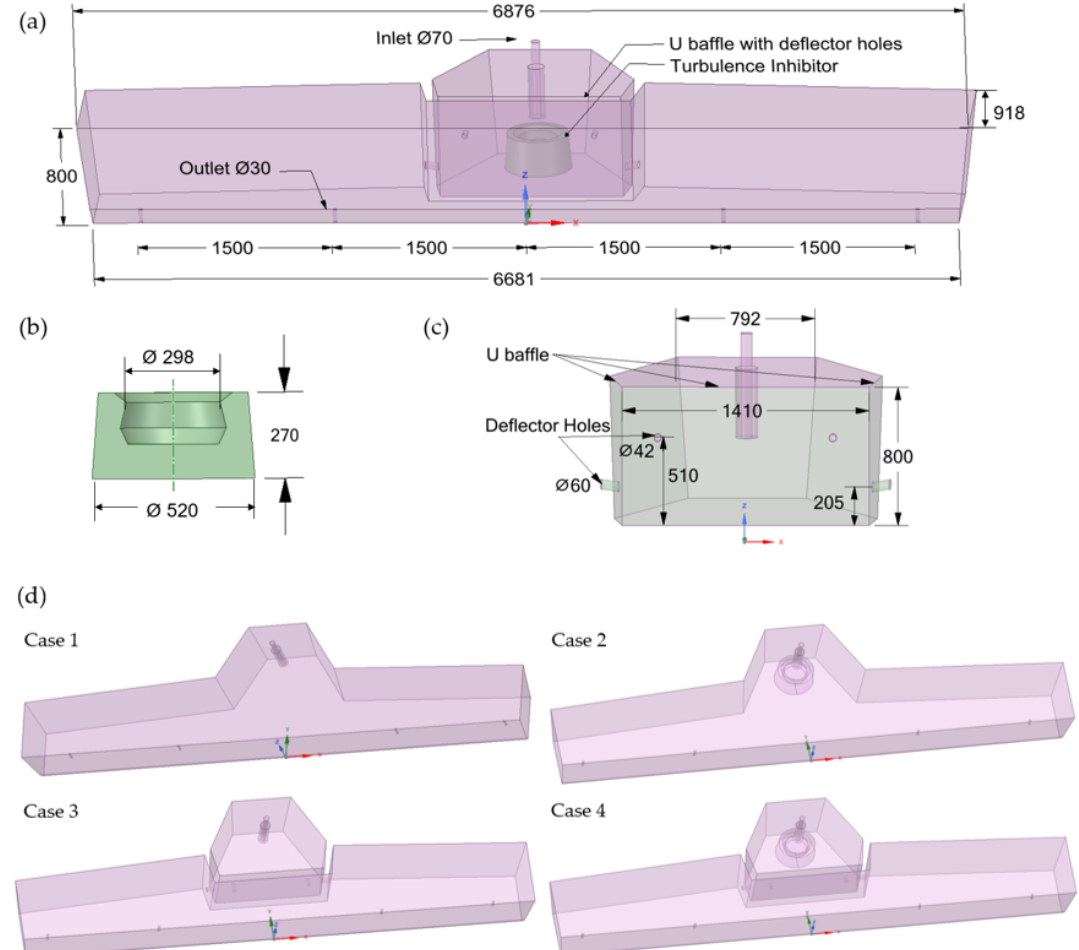
Figure 2. ( a ) Dimensions of in ‐ plant 5 ‐ strand tundish including turbulence inhibitor and U ‐ baffle with deflector holes (unit: mm); ( b ) turbulence Inhibitor (unit: mm); ( c ) U ‐ baffle with deflector holes (unit: mm); ( d ) Schematics of the four tundish configurations (Case 1–4).